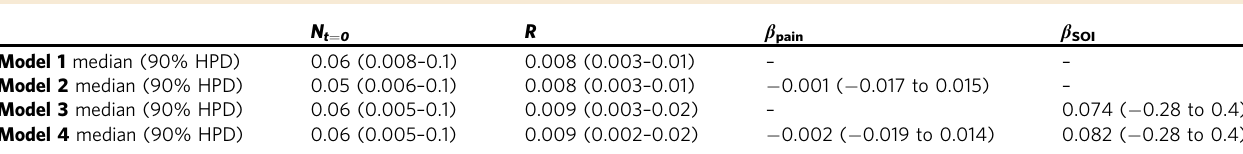
Table 1 Median and 90% highest posterior density (HPD) estimates for models with non-normalized SPD using the uncalsample back-calibration method (see “ Methods ” ). Using a normalized SPD and the calsample method produces comparable results (see